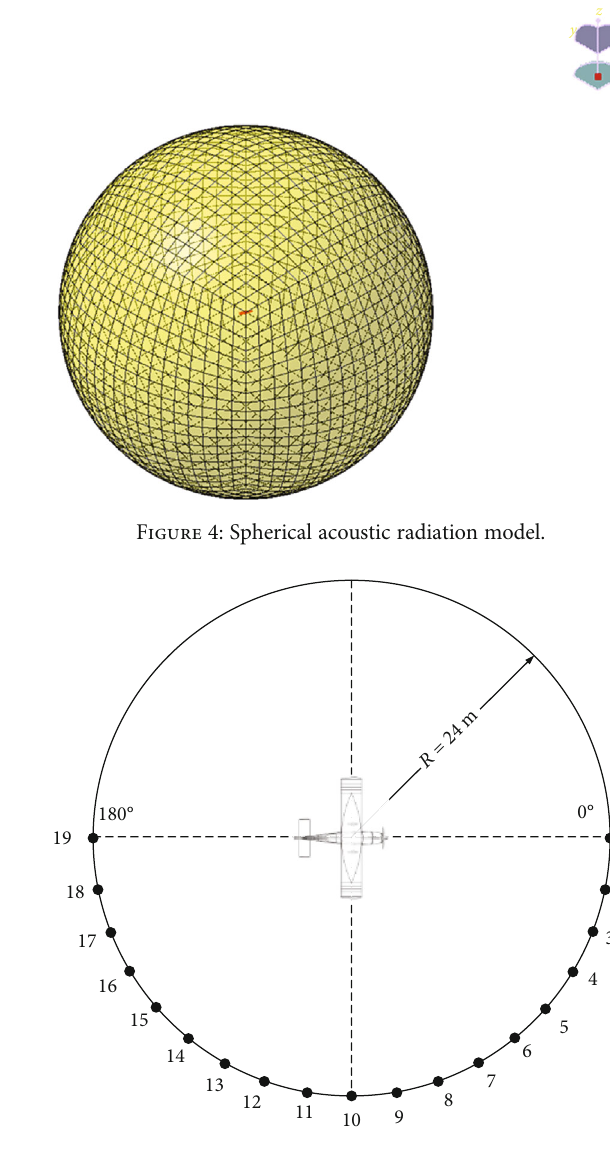
Figure 5: Noise receiver position schematic